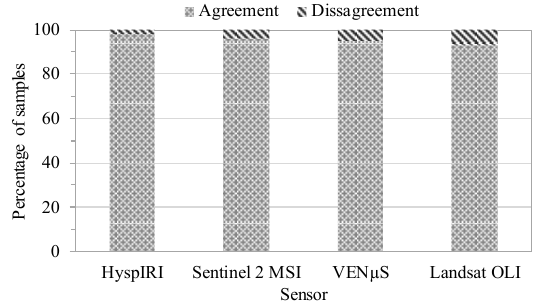
Figure 5: Accuracies of healthy, Infected and intermediately infected maize crops based on HyspIRI, (b) Sentinel-2 MSI, VENμS and Landsat OLI spectral settings based on Pontius and Millionres’s disagreement